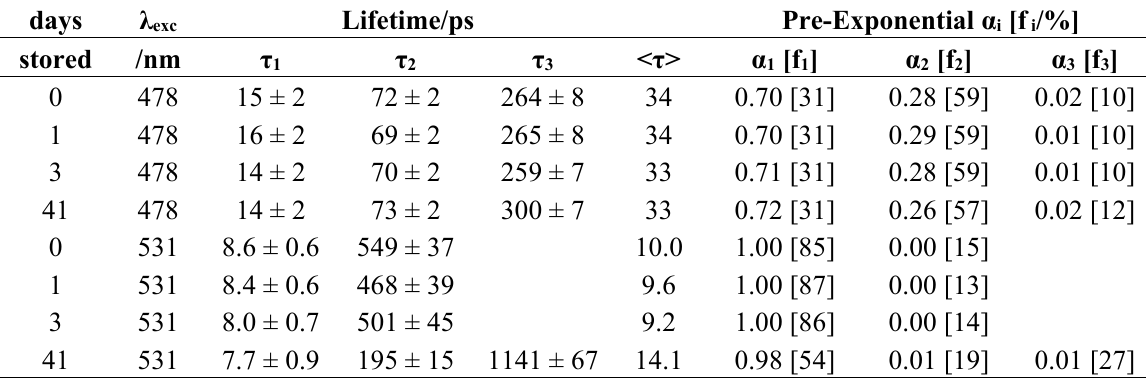
Table 2. Time-resolved decay parameters for stored raw vacuum beetroot samples obtained from fitting to Equation (1) using reconvolution